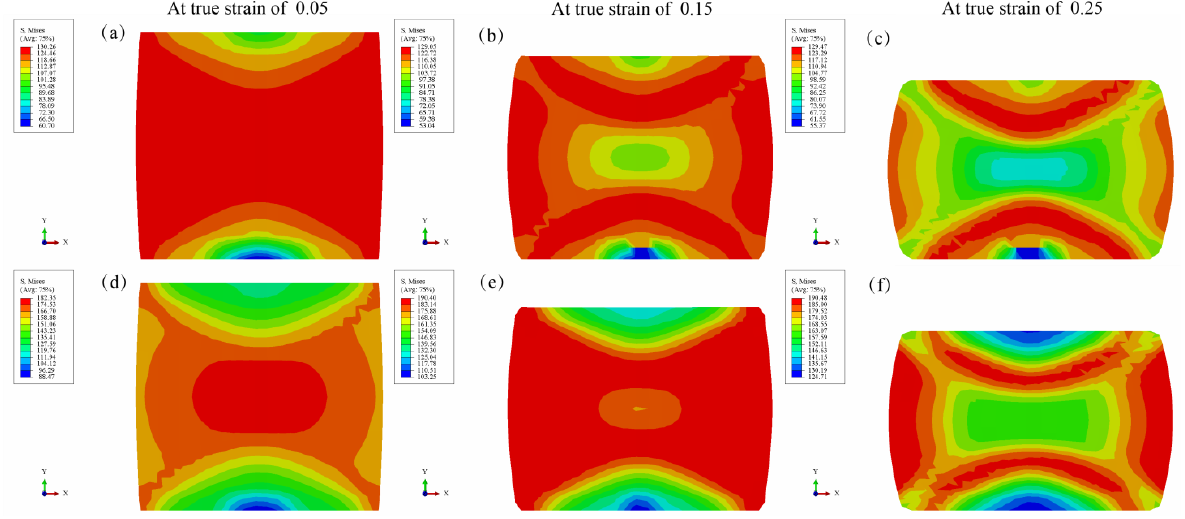
Figure 14. Stress distribution of the Mg 98.5 Zn 0.5 Y 1 alloy under different deformation conditions: ( a ) – ( c ) 200 °C and 0.001 s −1 ; ( d ) – ( f ) 200 °C and 1 s −1 . ( a – c ) 200 ◦ C and 0.001 s − 1 ; ( d – f ) 200 ◦ C and 1 s − 1